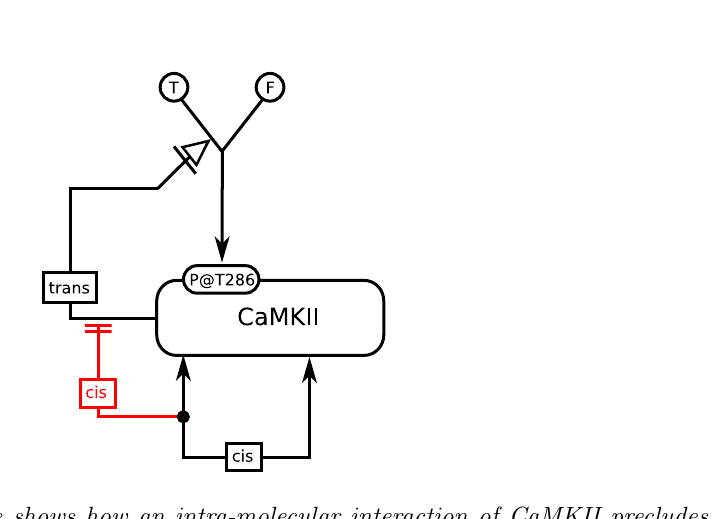
Figure 2.27: The Entity Relationship glyph for absolute inhibition .